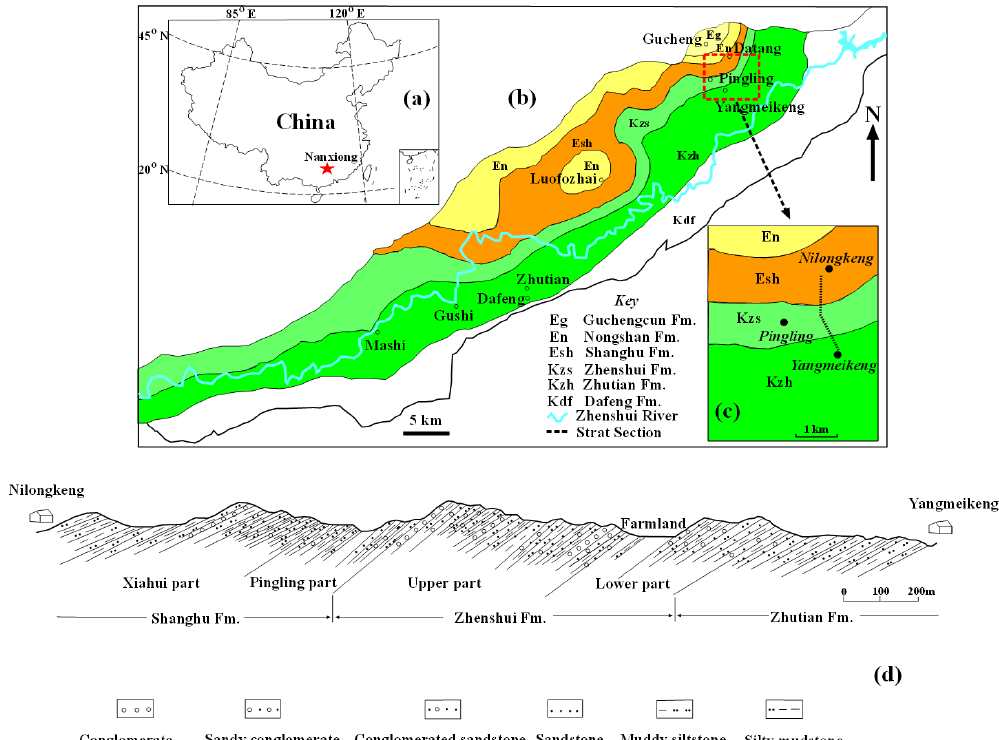
Figure 1. Sketch map of the Nanxiong Basin: (a) location of Nanxiong Basin, (b) stratigraphy of the Nanxiong Basin (from the Dafeng Formation to the Guchengcun Formation; modified from Li et al., 2010), (c) sampling route of the Datang profile, and (d) stratigraphy of the Datang profile (modified from Zhang et al., 2006). Note that the Zhutian Formation in the Datang profile is just the top part of the whole Zhutian